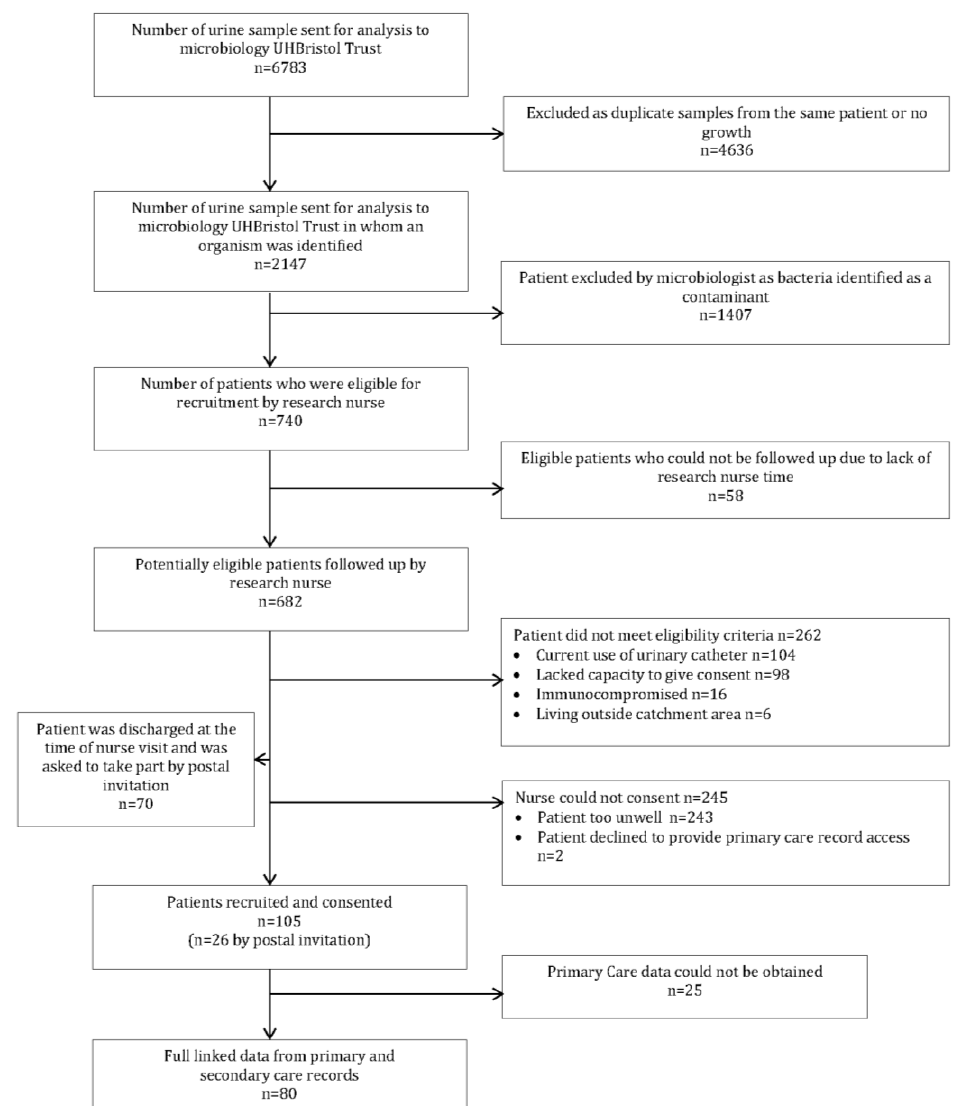
Figure 1. Diagram showing flow of participants through the